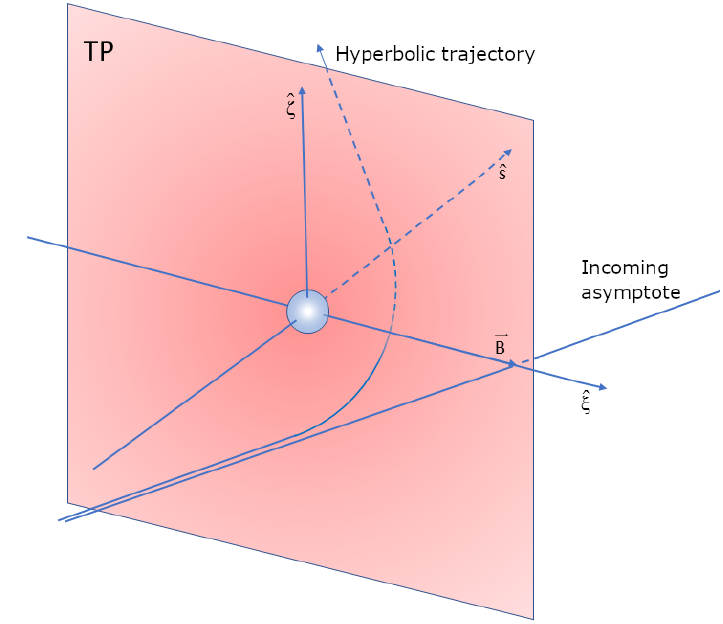
Figure 1. Target Plane for a generic planetary encounter, modelled as a scattering problem in a central field. The distance B between the center of the planet and the intersection between the TP and the incoming asymptote of the hyperbolic orbit is the impact parameter of the